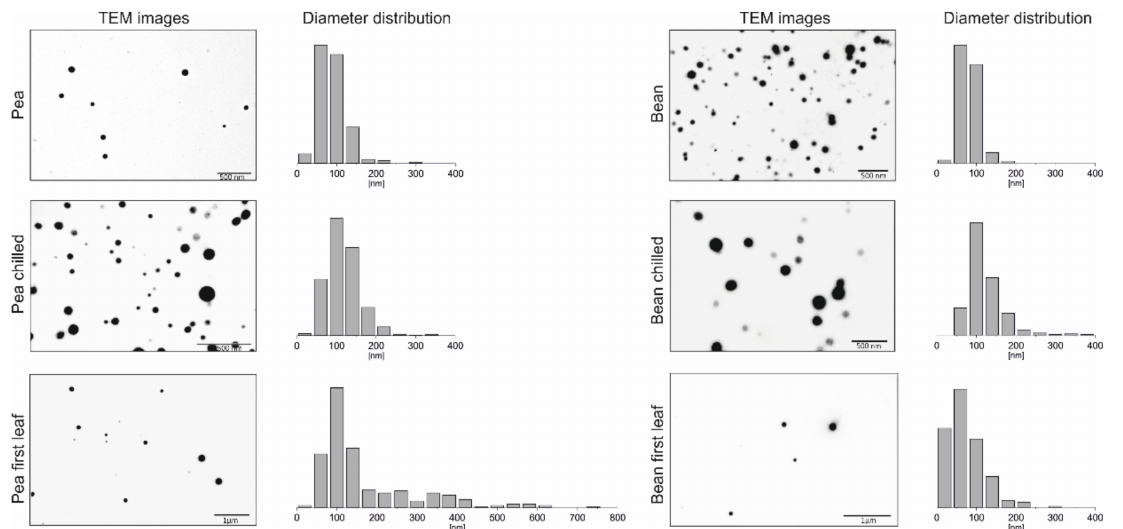
Figure 1. Visualisation and size distribution of plastoglobules (PGs) isolated from pea and bean first leaves and mature plants grown in control conditions and after the seventh day of chilling stress treatment. Isolated PGs were presented in electron micrographs obtained by transmission electron microscopy (TEM). The diameter of the visualised PGs structure was measured using the DigitalMicrograph 3.4 software (Gatan Inc., Pleasanton, CA, USA) and demonstrated on histogram charts; Y-axis represents % of size share in total counts; for total number of counts see Figure